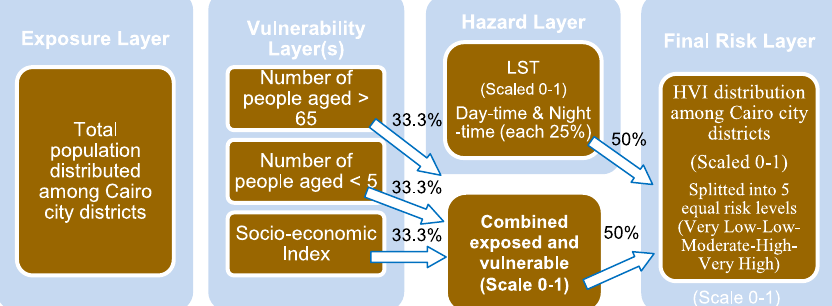
Fig. 9. Framework to develop the fi nal mapping of the Heat-related Vulnerability Index (HVI). Source: Adopted and developed from [17].